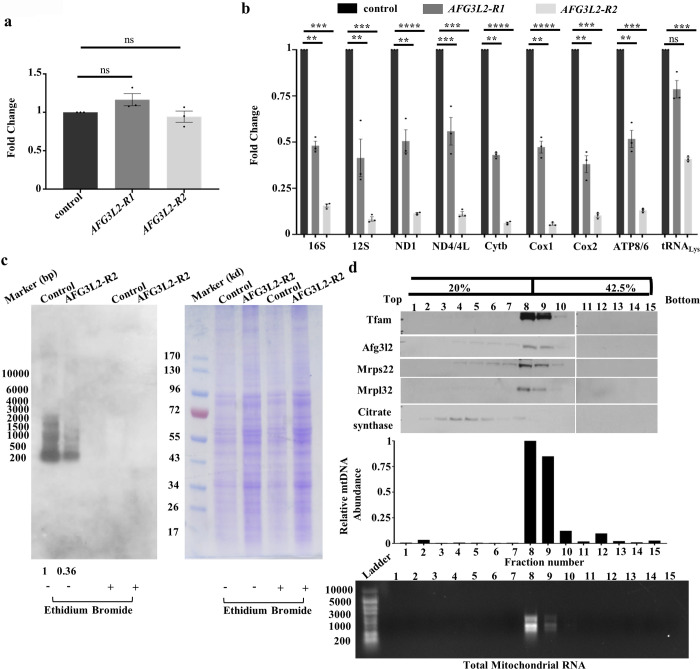
Afg3l2 deficiency impairs mitochondrial transcription.a. mtDNA abundance was compared in control (UAS-LUCIFERASE RNAi/da-Gal4) and AFG3L2-deficient (UAS-AFG3L2-R1 RNAi; da-Gal4 and UAS-AFG3L2-R2 RNAi/da-Gal4) pupae using RT-PCR (N = 3 independent groups of 5 pupae). Statistical significance was determined by one way ANOVA Tukey's test for multiple comparison. b. Quantification of mitochondrial RNA levels in control (UAS-LUCIFERASE RNAi/da-Gal4) and AFG3L2-deficient (UAS-AFG3L2-R1 RNAi; da-Gal4 and UAS-AFG3L2-R2 RNAi/da-Gal4) pupae using qRT-PCR (N = 3 independent groups of 5 pupae, **p < 0.005, ***p < 0.0005, ****p < 0.0001 by one way ANOVA Tukey's test for multiple comparison). c.
In organello transcription analysis using mitochondria from control (UAS-LUCIFERASE RNAi/da-Gal4) and AFG3L2-deficient (UAS-AFG3L2-R2 RNAi/da-Gal4) pupae in the presence and absence of ethidium bromide, a specific inhibitor of mitochondrial transcription. The right panel shows a Coomassie-stained gel from the same mitochondrial preparations to normalize protein loading (control samples defined as 1.0). d. Mitochondrial protein extracts isolated from control (UAS-LUCIFERASE RNAi/da-Gal4) pupae were subjected to iodixanol density gradient analysis. Fractions from the gradient were subjected to western blot analysis (top panel) using the indicated antisera (top panel), qPCR to quantify mtDNA abundance (middle panel), or denaturing agarose gel electrophoresis to identify mitochondrial RNA-containing fractions (bottom panel).